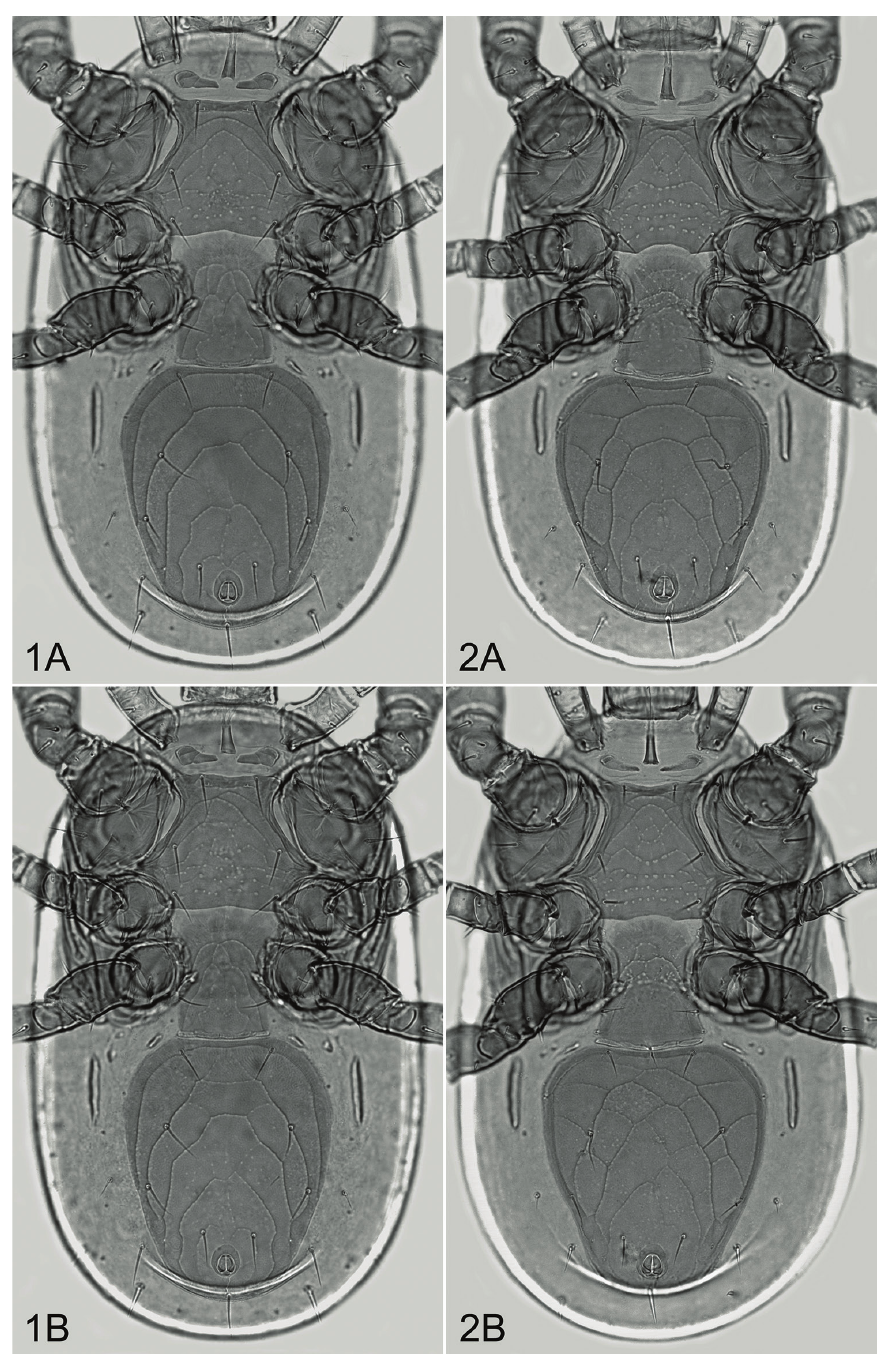
alis sp. n. Not to scale A, B variant